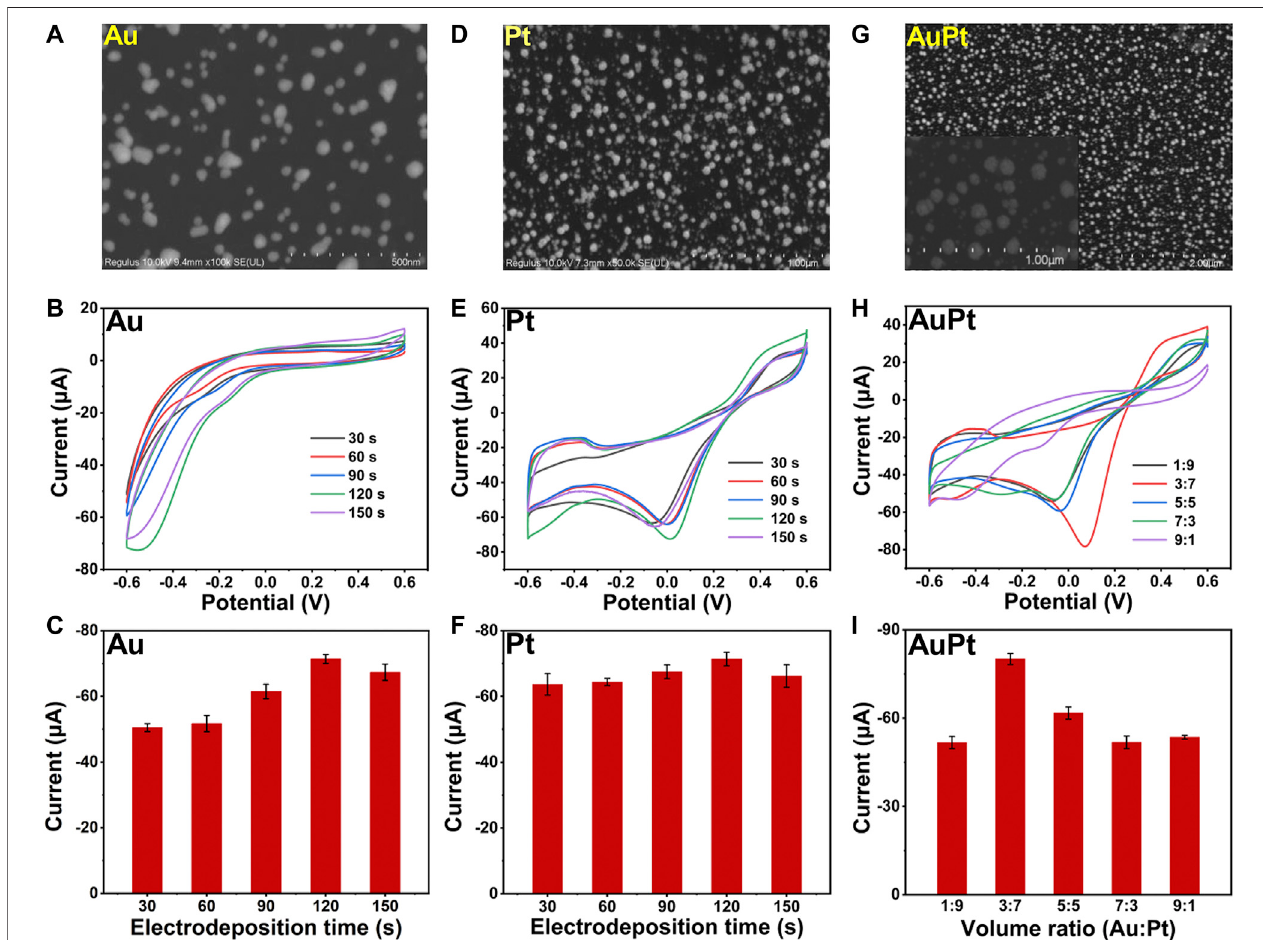
FIGURE 1 | (A) SEM images of Au NPs. (B,C) The CV curves and histograms of reduction peak current responses of Au/GCE for 2 mM H 2 O 2 with different electrodepositiontime(t=30,60,90,120,and150 s)( n =3). (D) SEMimagesofPtNPs. (E,F) TheCVcurvesandhistogramsofreductionpeakcurrentresponsesofPt/ GCE for 2 mM H 2 O 2 with different electrodeposition time (t = 30, 60, 90, 120, and 150 s) ( n = 3). (G) SEM images of Au 3 Pt 7 NPs. (H,I) The CV curves and histograms of reduction peak current responses of Au 3 Pt 7 /GCE for 2 mM H 2 O 2 with different volume ratio of Au NPs : Pt NPs (1:9, 3:7, 5:5, 7:3, and